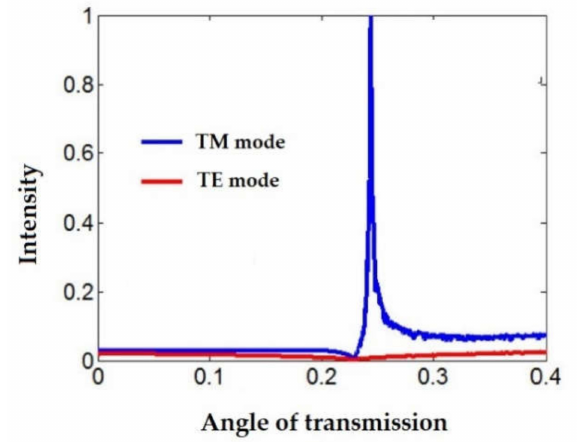
Figure 4. Demonstration of TE and TM